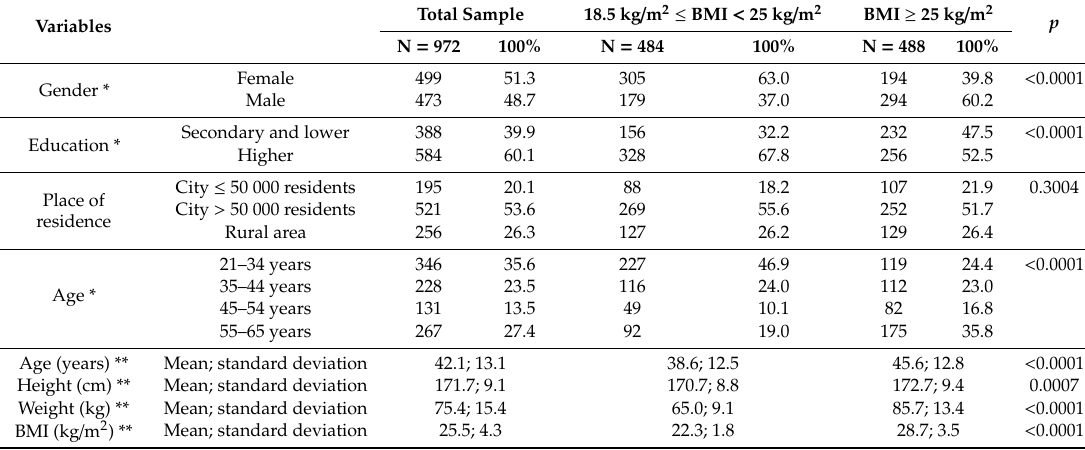
Table 1. Characteristics of the study sample.